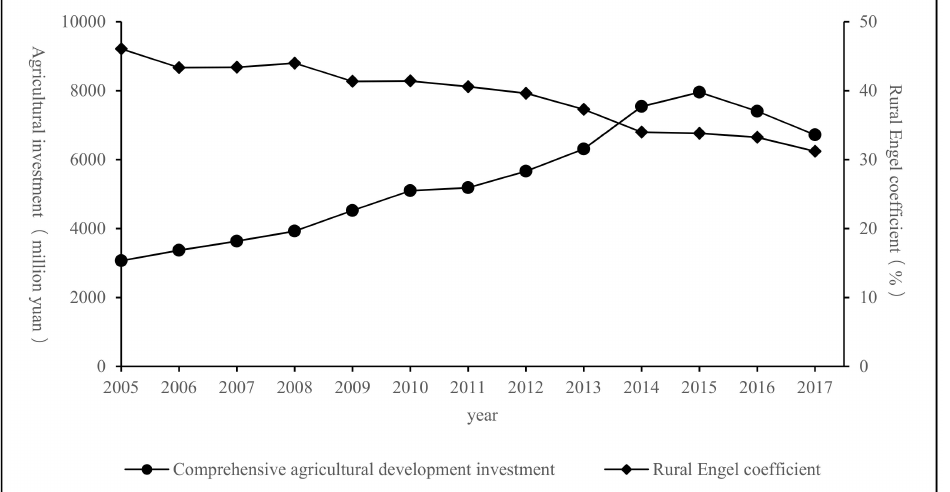
Figure 4. Agricultural investment and the rural Engel